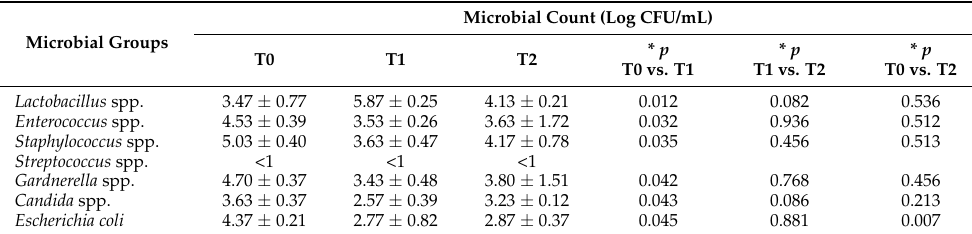
Figure 3. Frequencies of patients with Nugent score higher than 6 at T0 (baseline), T1 (15 days after the start of treatment (T1), and T2 (7 days after the end of treatment) sampling times. Table 2. Microbial count and ANOVA significance of the vaginal discharge samples collected at baseline (T0), 15 days after the start of treatment (T1), and 7 days after the end of oral SYNBIO ® administration (T2). Data are shown as mean and standard